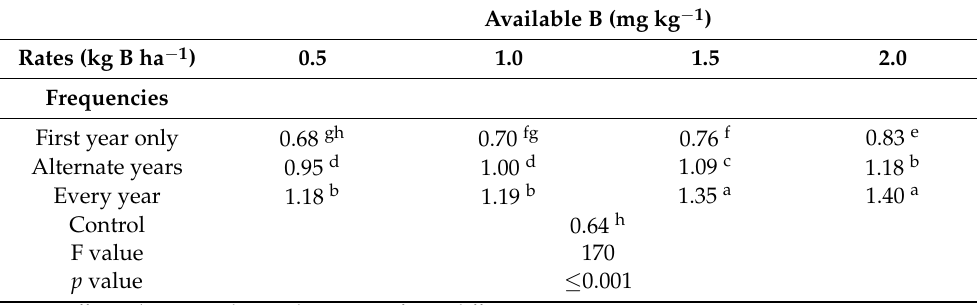
Table 3. Available B in soil as affected by various dosages of B addition to the groundnut-cabbage cropping system.